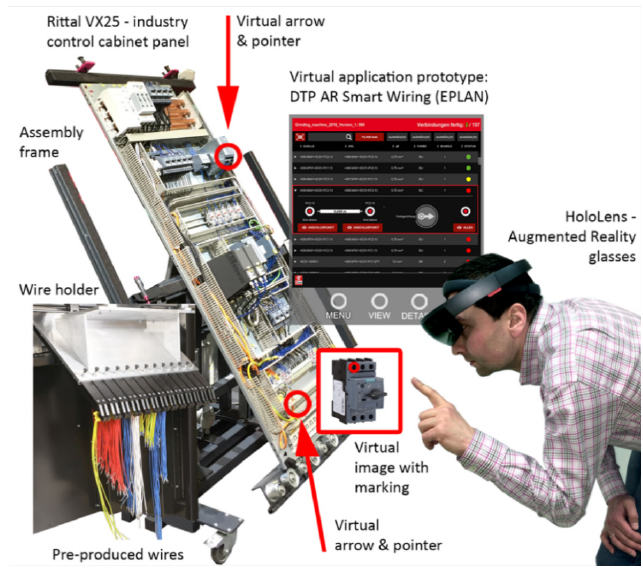
Figure 4. Visualization of the production station with the DTPoland AR Smart Wiring 4.0